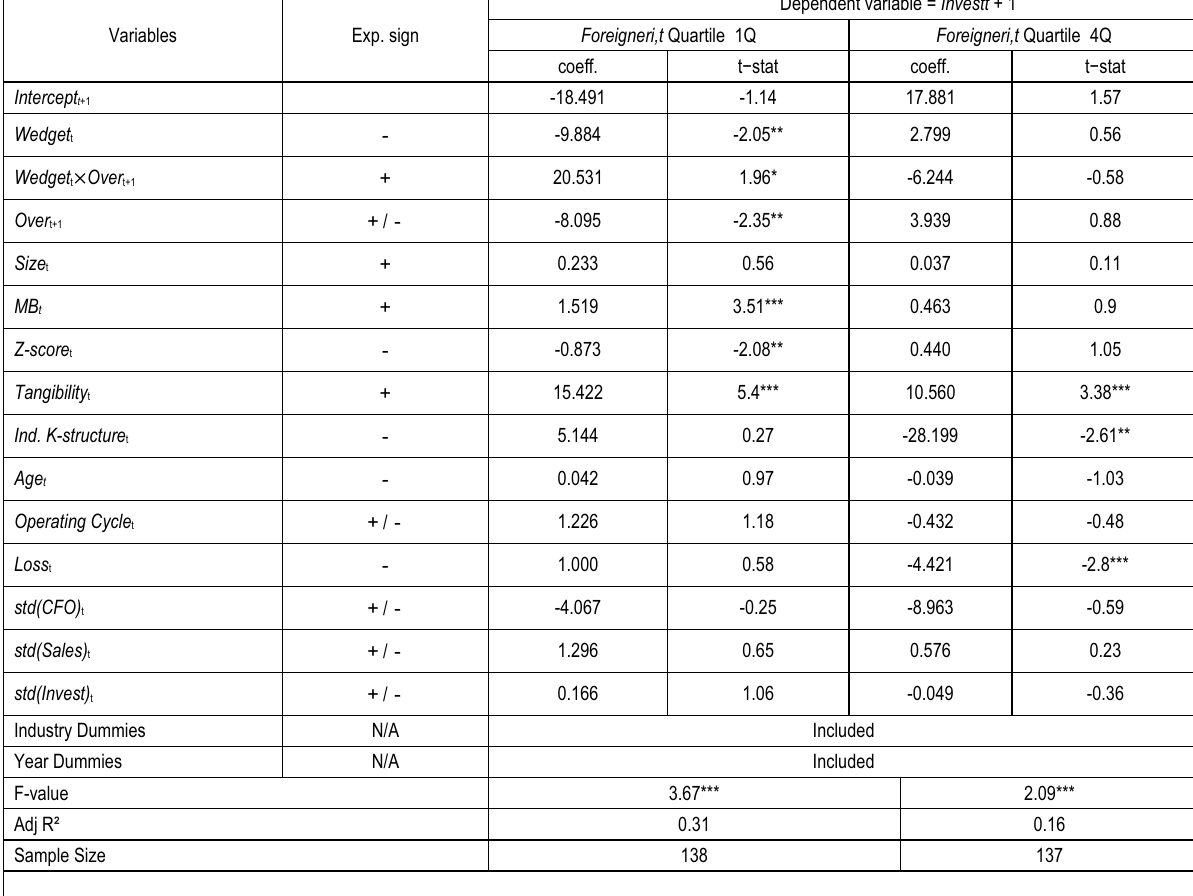
Table 4. The effect of controlling shareholders’ ownership with foreign ownership on investment efficiency